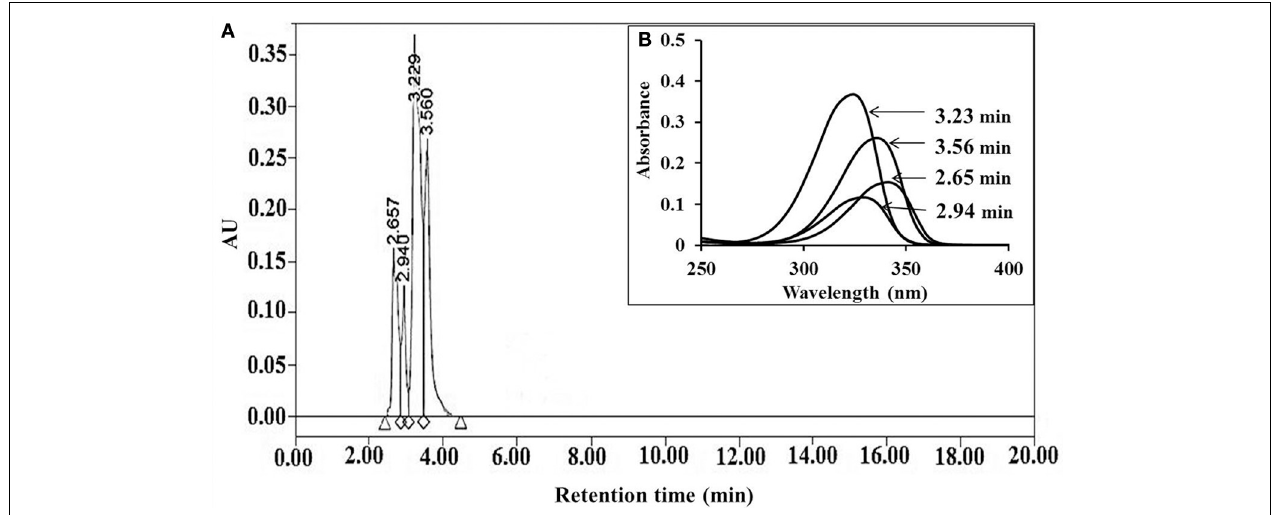
FIGURE 2 | HPLC chromatogram of MAAs extracted from Bryocladia sp., showing retention times 2.65, 2.94, 3.56, and 3.23min (A) with corresponding absorption maxima 340, 328, 335, and 323nm, respectively (B).